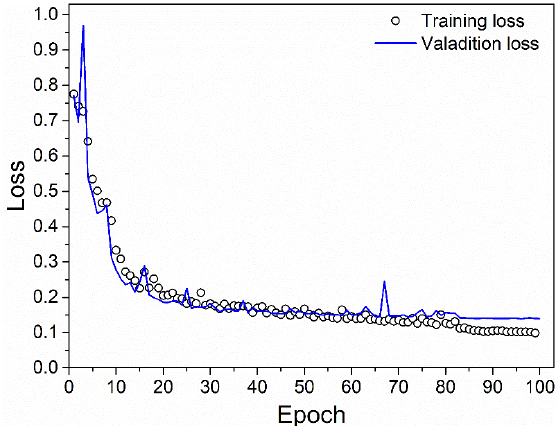
Figure 7. Training and validation losses as a function of epoch.